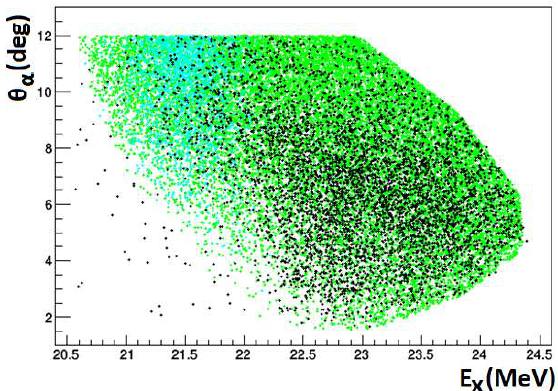
Fig. 2. Horizontal position ( X foc ) versus residual energy ( E resid ) spectrum for a single silicon detector of the FPD after applying the graphical selection on Z = 2 highlighted in Fig.1. The selection condition of 4 He events is illustrated by the solid black line.